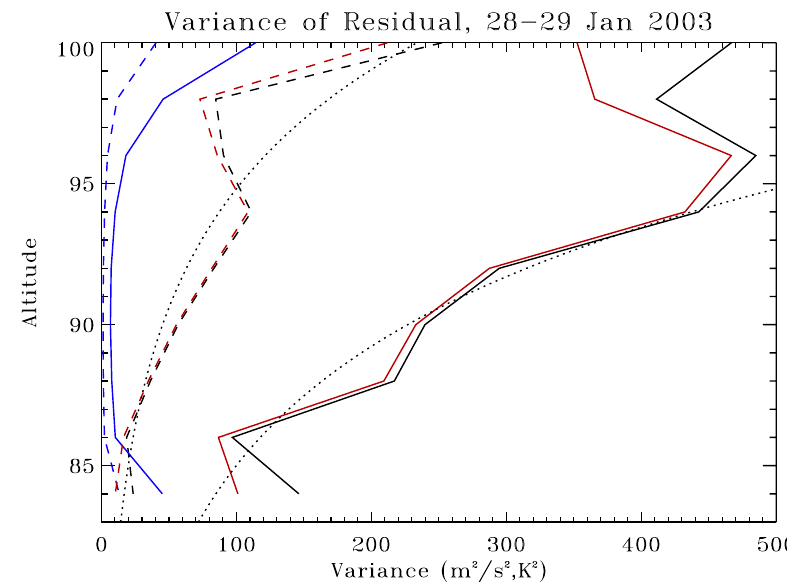
Fig. 7. The variance of the residual temperature (dashed) and wind (solid) fields increases strongly with altitude from 86 to 96km. Below 86km and above 96km, the instrument mean square error (blue lines) increases rapidly, so it is subtracted from total variance to give the red lines, but do not put much weight in the top or bottom points, as they depend on an accurate error estimate. The dotted lines show the growth rate for an undamped